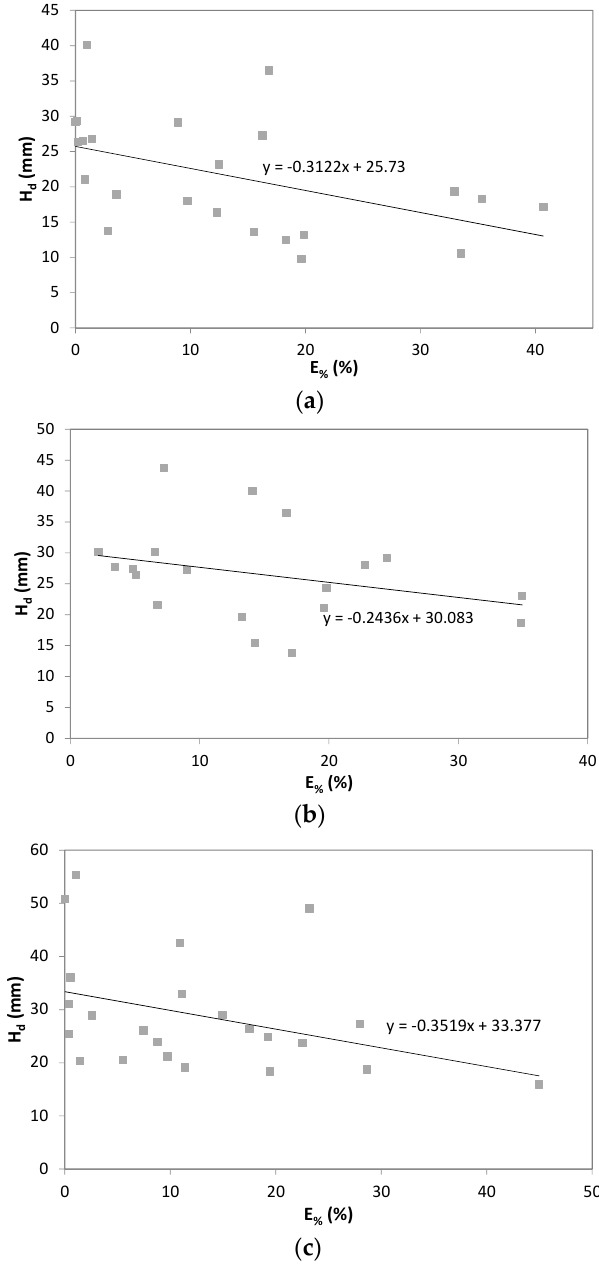
Figure 10. Relation between the annual maximum rainfall depth, H d , and the underestimation error, E % . ( a ) Cerbara station, t a = d = 30 min. ( b ) Montecucco station, t a = d = 60 min. ( c ) Casa Castalda station, t a = d = 60 min. The best interpolating linear function is also plotted.